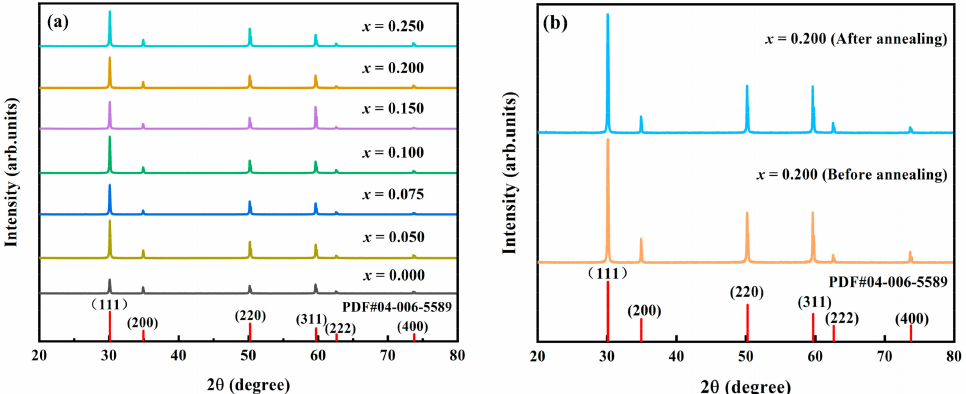
Figure 2. ( a ) XRD patterns of (ZrO 2 ) 92 (Y 2 O 3 ) 8 − x (Tb 4 O 7 ) x ( x = 0.000–0.250) crystal powders before annealing. ( b ) XRD pattern of (ZrO 2 ) 92 (Y 2 O 3 ) 7.800 (Tb 4 O 7 ) 0.200 crystal powders before and after